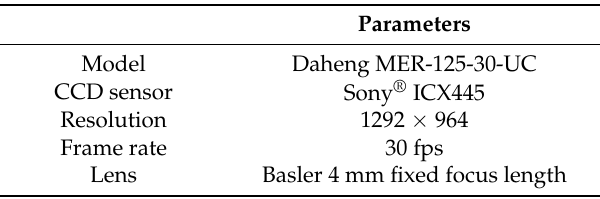
Table 1. Parameters of the vehicle-mounted